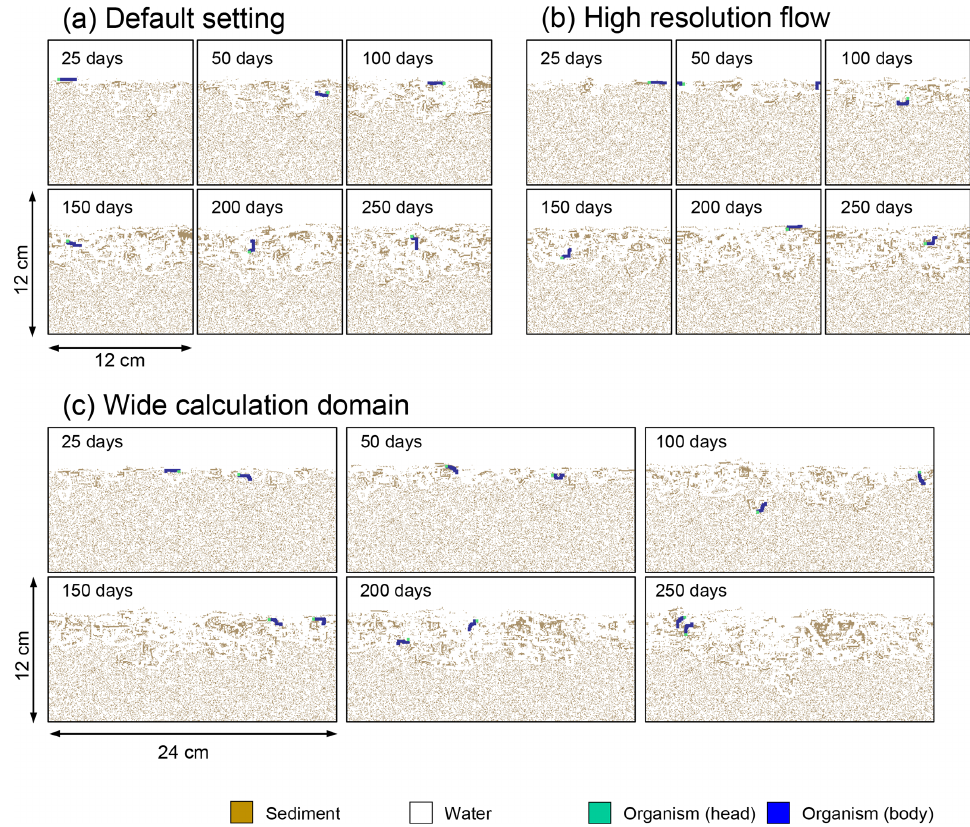
Figure B3. Time evolution of burrow geometry in simulations (a) with the default settings, (b) assuming a higher resolution (480 × 480) for the water flow calculation with otherwise default settings, and (c) assuming a wider calculation domain (24 × 12cm 2 ) and two deposit feeders with otherwise default